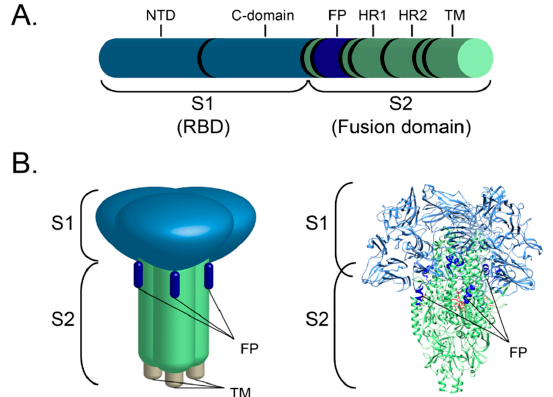
Figure 2. The FCoV S gene and protein functional components. A schematic of the FCoV S gene ( A ) and the S protein ( B left), the S1 domain or RBD forms the head of the protein, while the S2 domain (fusion domain) forms the stalk of the protein. Trimeric structure of the S protein of HCoV-NL63 (PDB # 5SZS) ( B right). The structure of the transmembrane domain has not yet been solved. The two domains S1 (blue) and S2 (green), as well as the major functional components RBD (NTD and C-domain), FP (bright blue), HR1, HR2 and the transmembrane domain (TM) are noted.